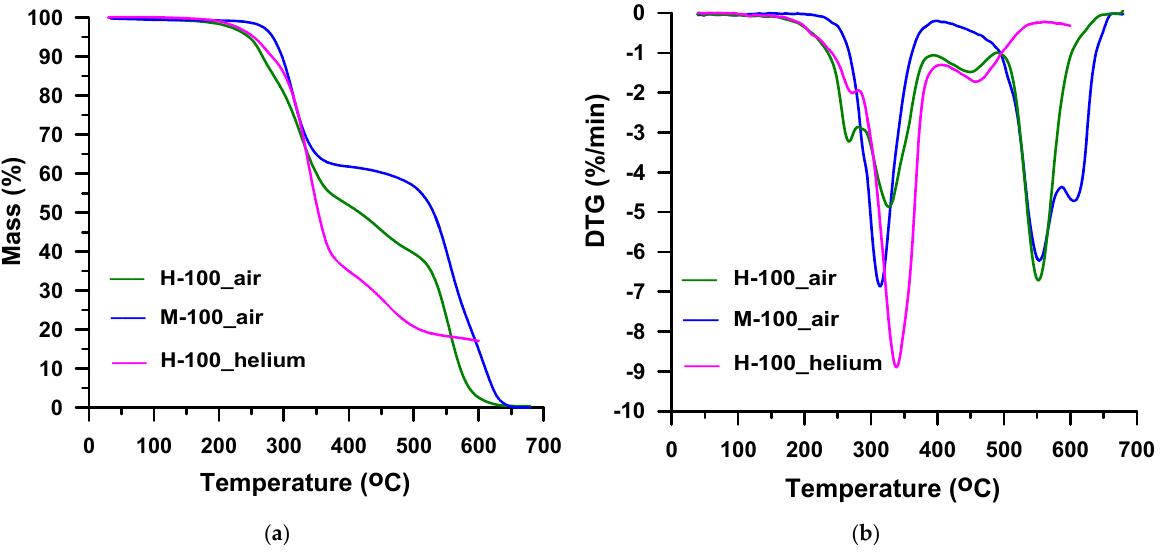
Figure 3. TG ( a ) and DTG ( b ) curves of the hard-segment-type TPUs obtained in helium and air. The FTIR spectrum recorded during the first decomposition step of the H-100 sample in helium (Figure 4b, T max = 272 ◦ C) shows bands typical of carbonyl sulfide (at 2072 and 2047 cm − 1 , characteristic of the asymmetric and symmetric C=O stretching vibrations, respectively), carbon dioxide (at 2359–2310 cm − 1 , connected with asymmetric stretching vibrations and at 669 cm − 1 —with the degenerate bending vibrations), primary alcohols (at 1055 cm − 1 , related to the C-OH stretching vibrations) and water (at ~4000–3500 and ~1800–1300 cm − 1 , associated with stretching and bending vibrations,